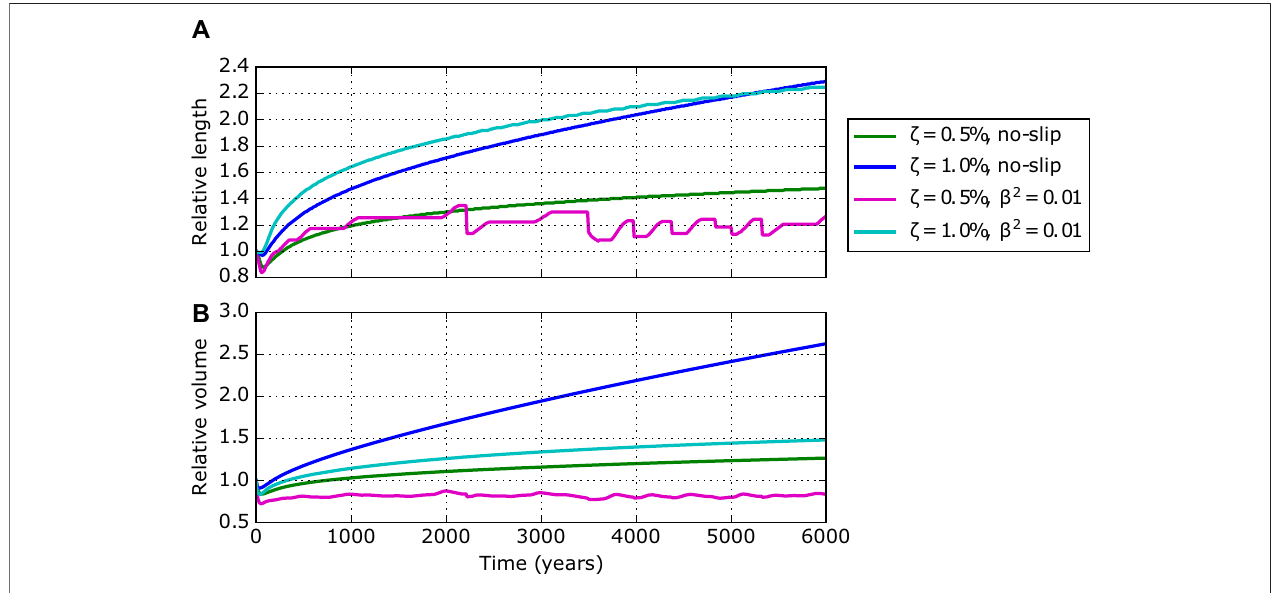
FIGURE 5 | (A) Glacier length and (B) volume evolution of simulated debris-covered glaciers for different englacial debris concentrations ( ζ (cid:1) 0.5% and 1.0%) and differentbasalconditions(no-sliporslidingwith β 2 (cid:1) 0.01).Lengthsandvolumesarerelativetothecorrespondingclean-iceequilibriumstate. After6,000yearsevolution none of the systems is in equilibrium. The system with ζ (cid:1) 0.5% and β 2 (cid:1) 0.01 (magenta) is in an erratically oscillating state. The other three systems are in an advancing state.